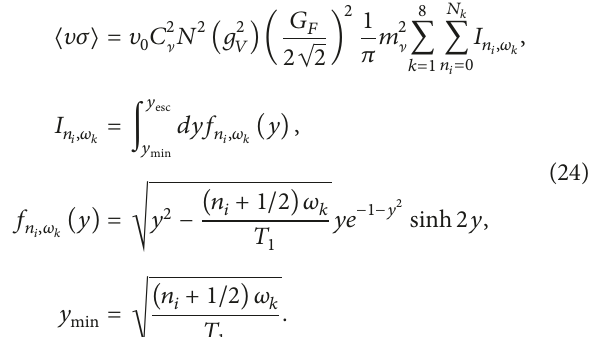
(𝑦) are exhibited in Figure 2. The Table 1. The functions 𝑓 𝑛 𝑖 ,𝜔 𝑘 relevant integrals are 𝐼 𝑛 (𝜔 1 ) = (1.170, 0.972, 0.785, 0.621) for 𝑛 = 0, 1, 2, 3 , 𝐼 𝑛 (𝜔 2 ) = (1.032, 0.609) , for 𝑛 = 0, 1 , (𝜔 ) = (1.025, 0.592) , for 𝑛 = 0, 1 , and 𝐼 (𝜔 ) = 𝐼 𝑛 3 0 𝑘 (0.979, 0.970, 0.934, 0.932, 0.929) for 𝑘 = 4, . . . , 8 . Thus